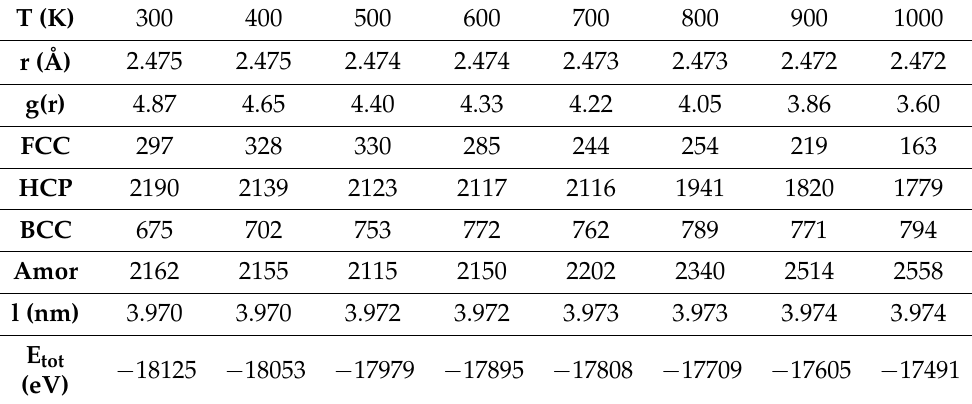
Table 2. The structural characteristics and phase transition of bulk Cu 5324 material at different temperatures. T